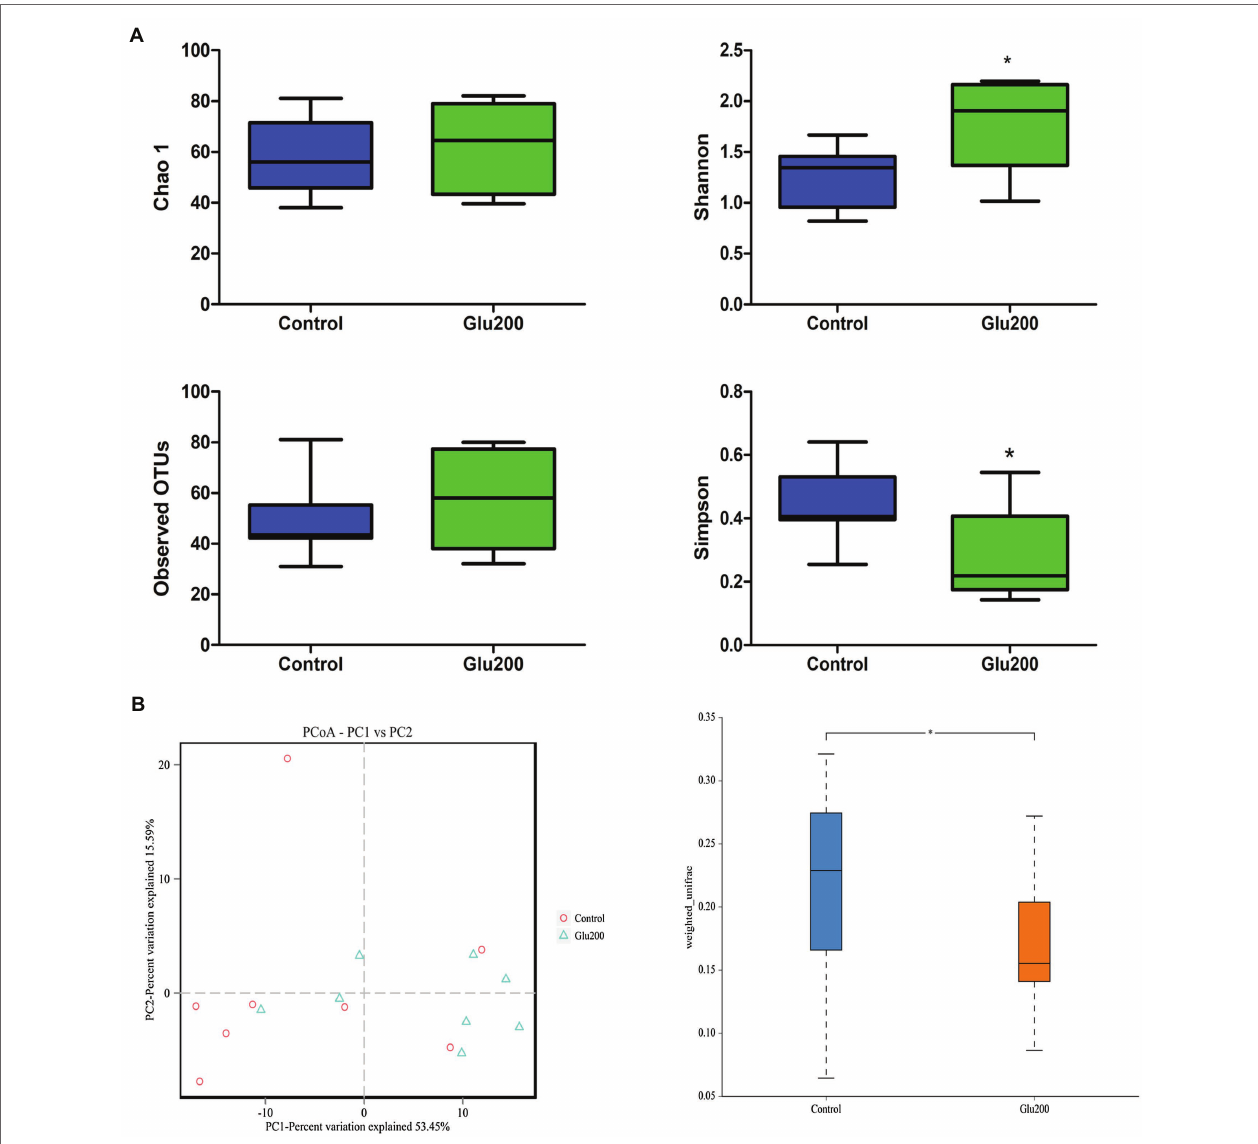
FIGURE 1 | Differences in bacterial community diversity, richness, and structures in the ileum of breeder laying hens fed with or without dietary Glu200. (A) Community diversity and richness between Control and Glu200 groups. (B) PCoA of bacterial community structure between Control and Glu200 groups. Each symbol represents each gut microbiota. Red symbols represent the Control group, and blue symbols represent the Glu200 group. Control: the basal diet; Glu200: the basal diet supplemented with 200 mg/kg yeast β -glucan. *means significant difference between